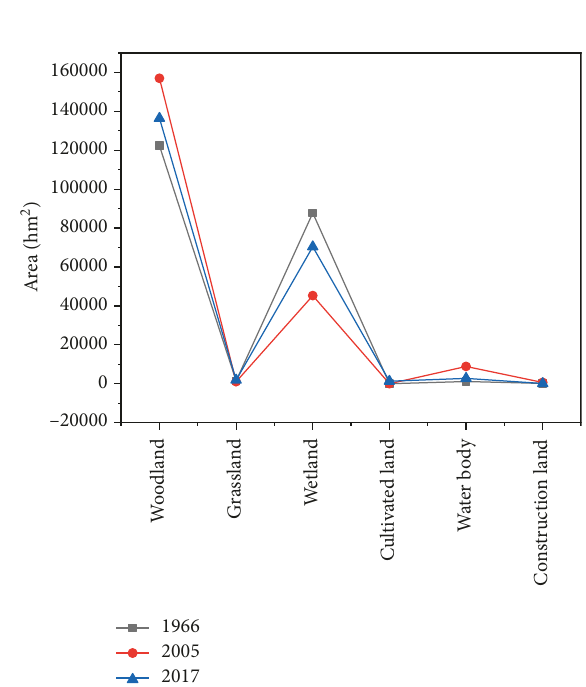
Figure 2: Area histogram of each land cover type in 1996, 2005, and